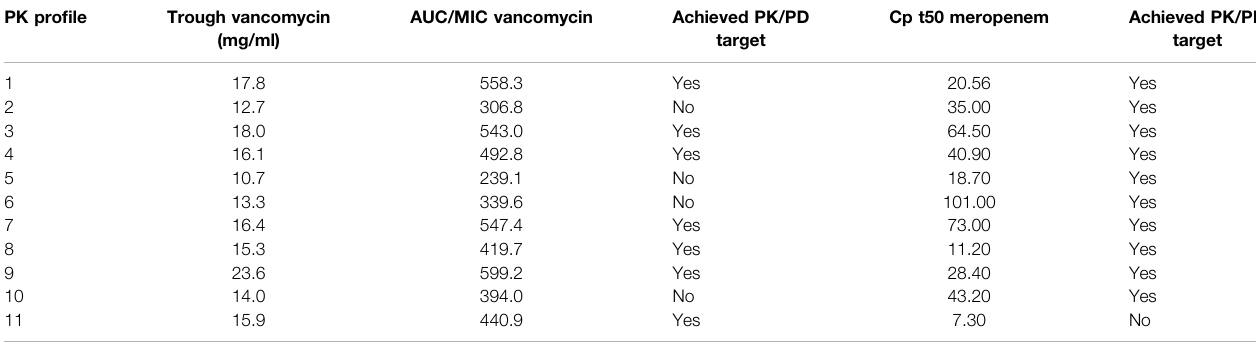
TABLE 7 | Pharmacokinetic/pharmacodynamic results for vancomycin and meropenem. PK pro fi le Trough vancomycin